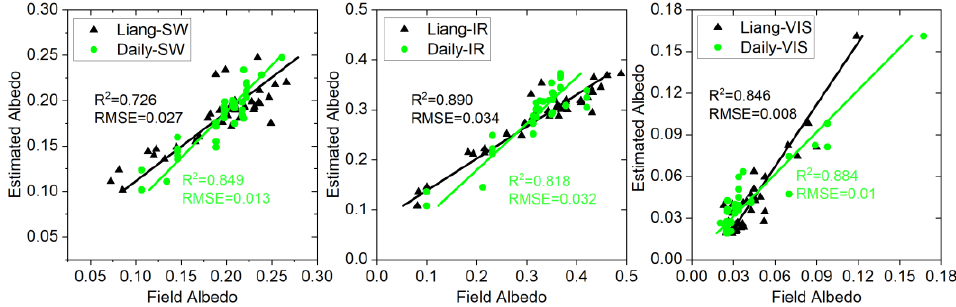
Figure 7. Comparisons of the estimated and field-measured broadband albedo.